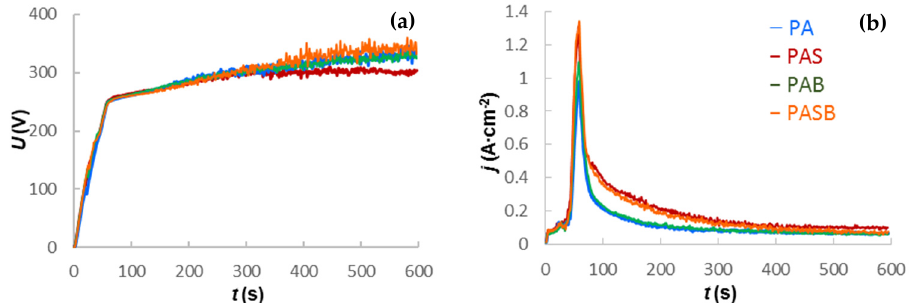
Figure 1. Electrical characteristics for the PEO process of Zr1%Nb samples: ( a ) RMS voltage; ( b ) RMS current density.